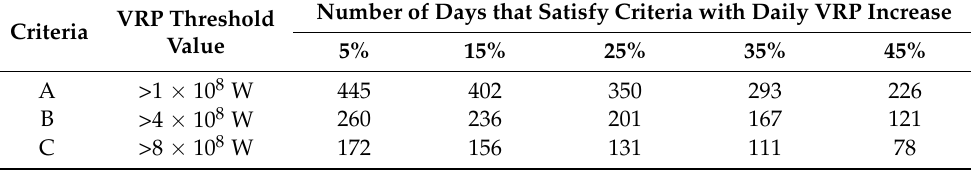
Table 1. Volcanic radiative power (VRP) threshold values and number of corresponding days within analysed Middle InfraRed Observation of Volcanic Activity (MIROVA) dataset for three VRP threshold values and 5 different daily increases in